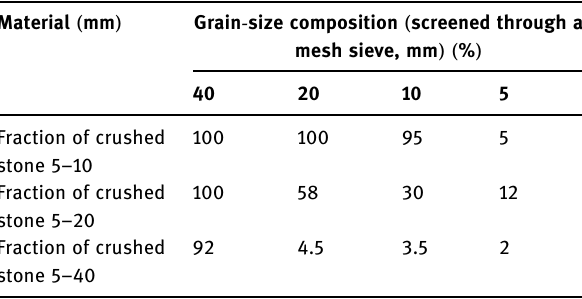
Table 4: Grain - size composition of the crushed stone Material ( mm )